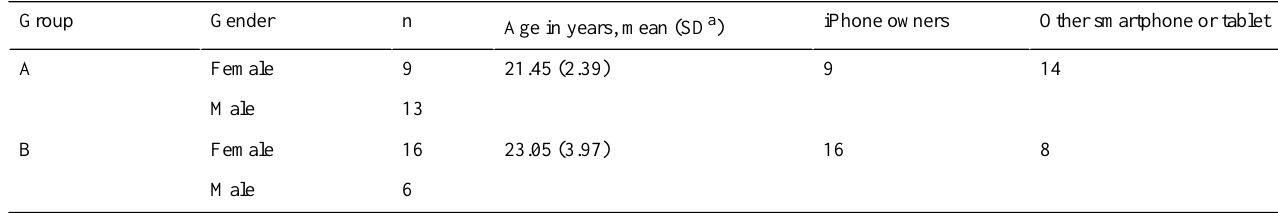
Table 2. Descriptive statistics of the participants